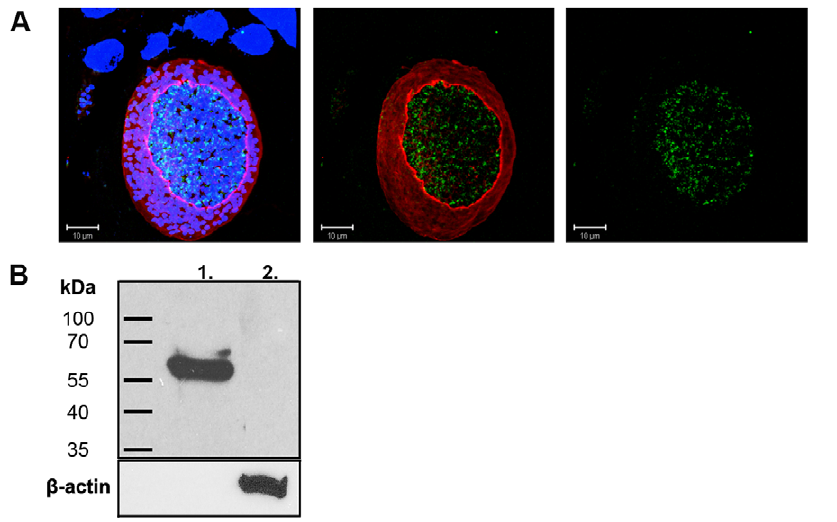
Figure 5. Expression of a parasite-encoded tyrosine hydroxylase in brain tissue cysts. (A) 3D projections of serial images of T. gondii tissue cysts within brain sections were triple stained with T. gondii encoded tyrosine hydroxylase (TgTH) antibody (green), DAPI (blue), and lectin (red). The panels (from left to right) show all three channels, the lectin and antibody, and TgTH antibody alone (green). Staining was not apparent in control sections that received only secondary antibody (data not shown). DAPI identified neuronal cells and the individual bradyzoites within the tissue cyst and lectin stained the surface of the cyst. (B) Western analysis for specificity of the custom antibody for TgTH. Recombinant protein from D 29TgAaaH2 [9] and mouse brain were probed with TgTH antibody. No bands were detected in uninfected mouse brain. b -actin was used as a loading control.